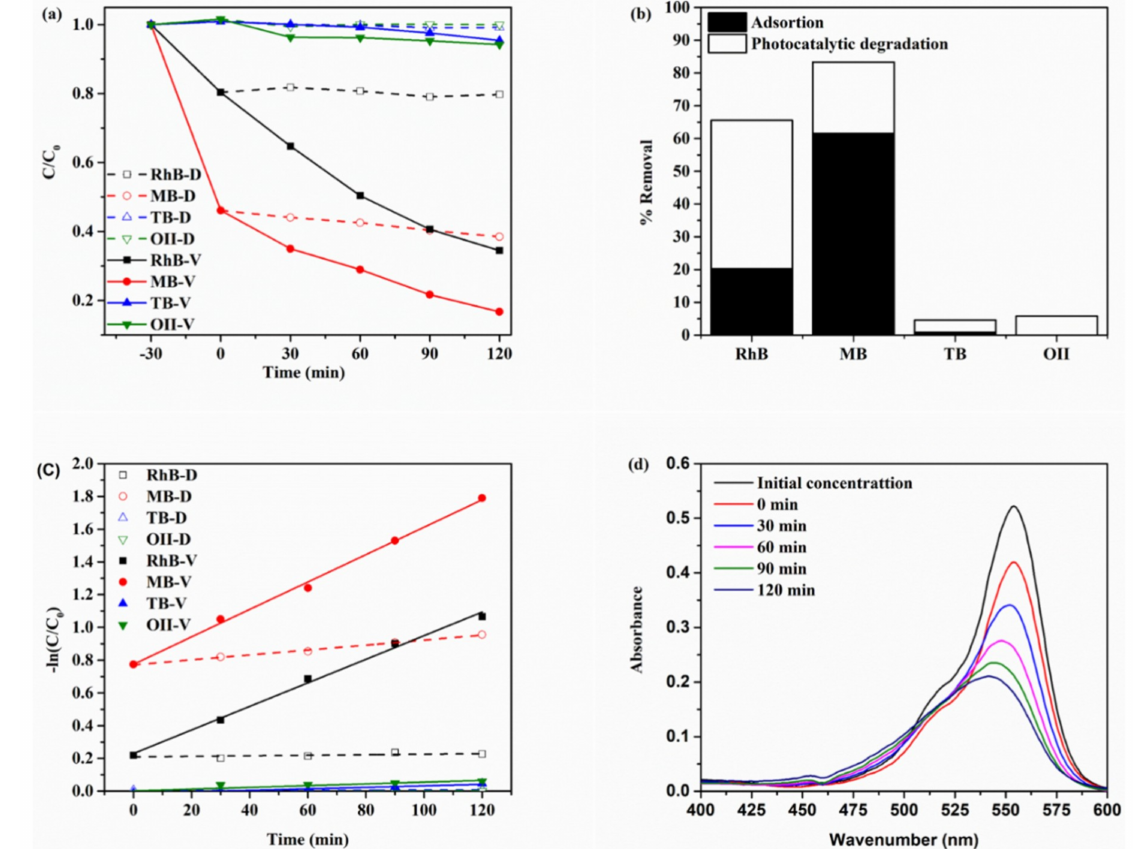
Figure 6. ( a ) Adsorption and photocatalytic degradation of various organic dyes over sepiolite as a function of time; ( b ) removal efficiency of various organic dyes over sepiolite after 120 min; ( c ) pseudo-first-order kinetic plot of various organic dyes over sepiolite; and ( d ) time-dependent changes in UV-Vis spectra of rhodamine B (RhB) in suspension of sepiolite under the visible light